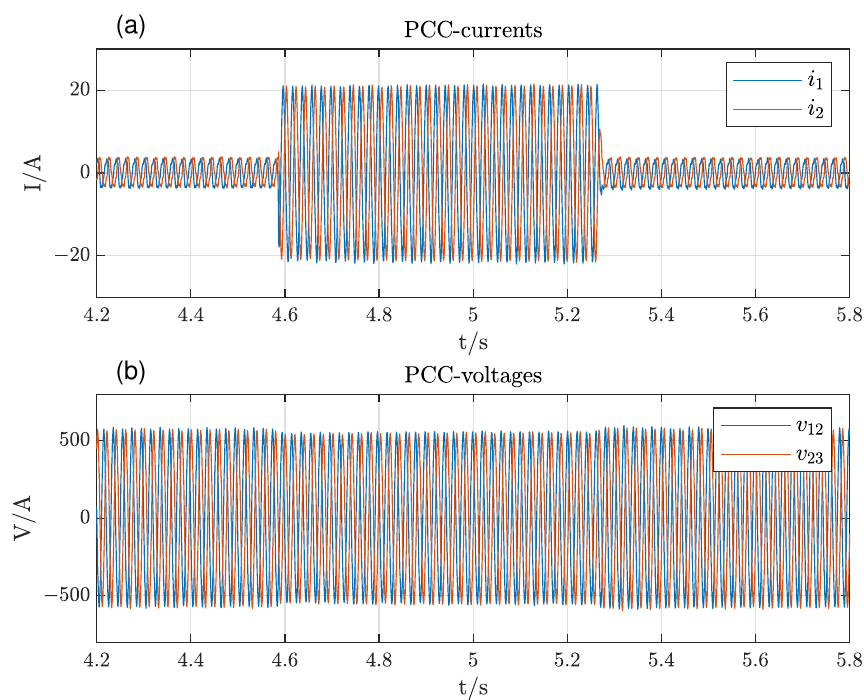
Figure 11. Islanding event at full power: ( a ) PCC-currents and ( b ) PCC-voltages. The system behavior at load changes in islanded mode is presented in Figure 12. The load has been changed from 20% to 100% and back within about 650 ms. During the full-load period, the voltage drops again slightly, but otherwise, no disruptive transients occurred.